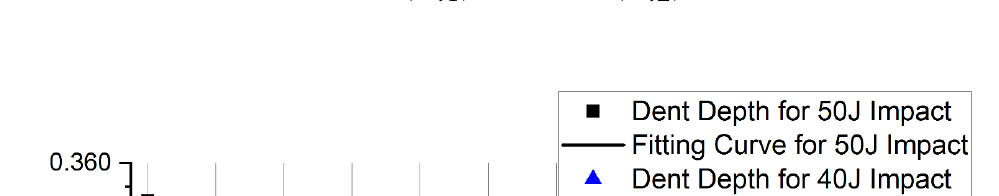
Figure 6. Pictures of 40 J impact case specimen: ( a ) view from impact side; ( b ) view from back side. By taking the data points of dent depths for the 50 J, 40 J, and 30 J impact cases, the following two-exponential-decay type equation (Equation (29)) is used with a curve fitting technique, which will help with dent depth calculation (in mm) for a given time (in h) (Figure 7).